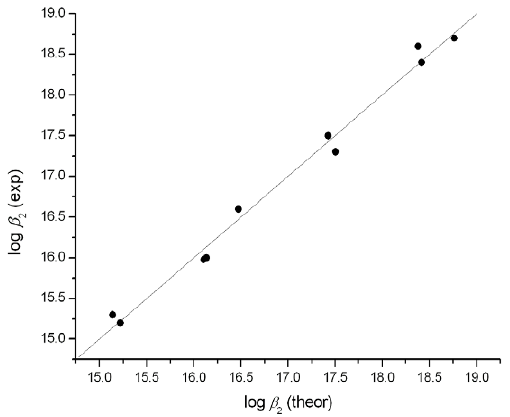
values for Ni(II) 2